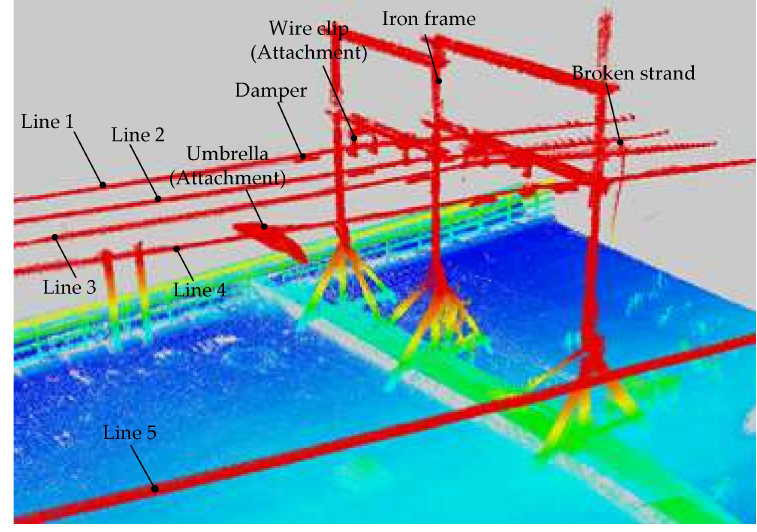
Figure 9. Point cloud of the second dataset.